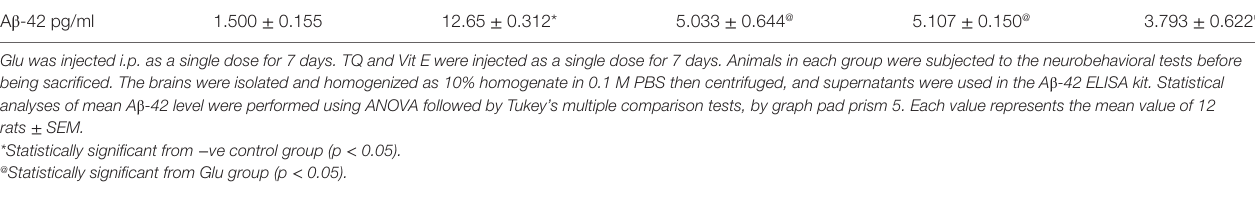
TaBle 7 | Effect of Glu, Vit E/Glu, TQ 2.5/Glu, and TQ 10/Glu on the A β -42 levels. groups − ve control glu